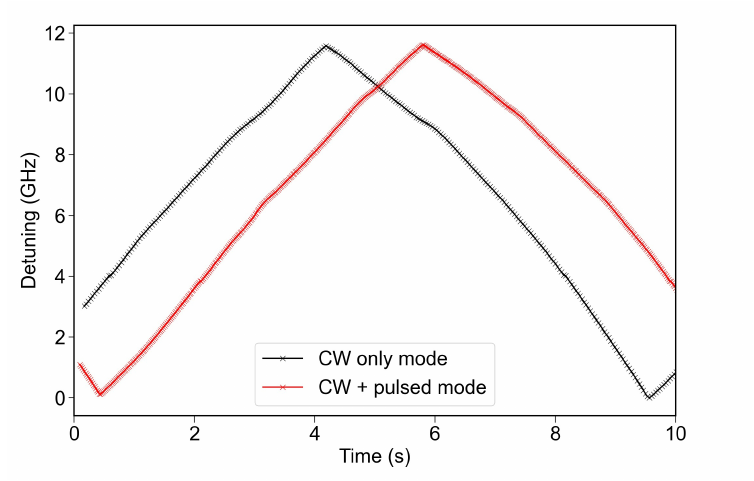
Figure 9. Slow frequency scan of the Ti:sapphire laser showing mode-hop free operation in CW and pulsed